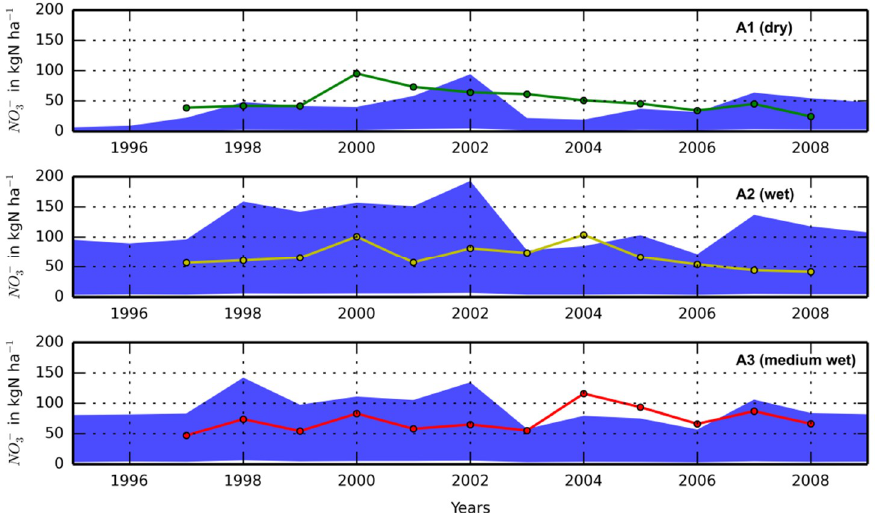
Figure 3. Confidence intervals (blue area) for the simulated annual NO 3 − uptake from groundwater for the plots A1, A2 and A3 (from top). Colored solid lines depict the minimum required NO 3 − uptake, which is necessary to close the deficit in the measured N budget. Additional information can be found in Tables A3 and A4.